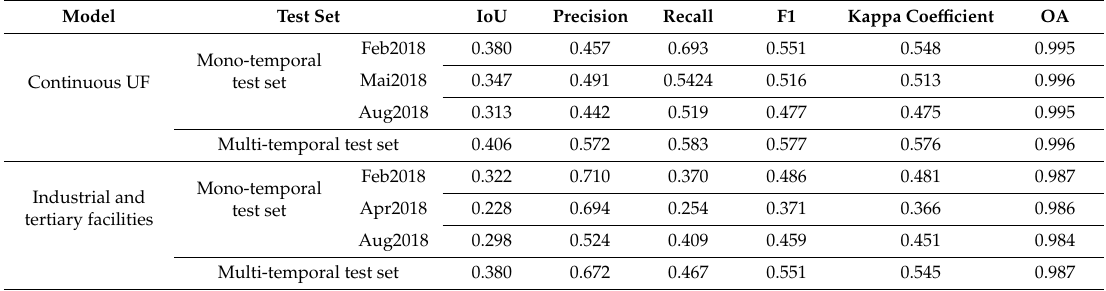
Table 11. Comparison between the mono and multi-temporal model in terms of evaluation metrics calculated over test